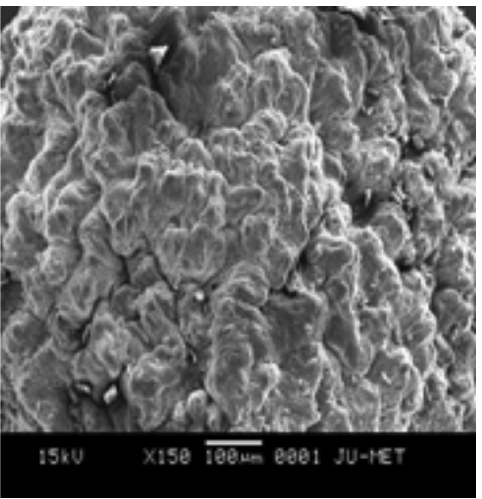
FIGURE 1 (a) - SEM photograph of beads before dissolution (F3).